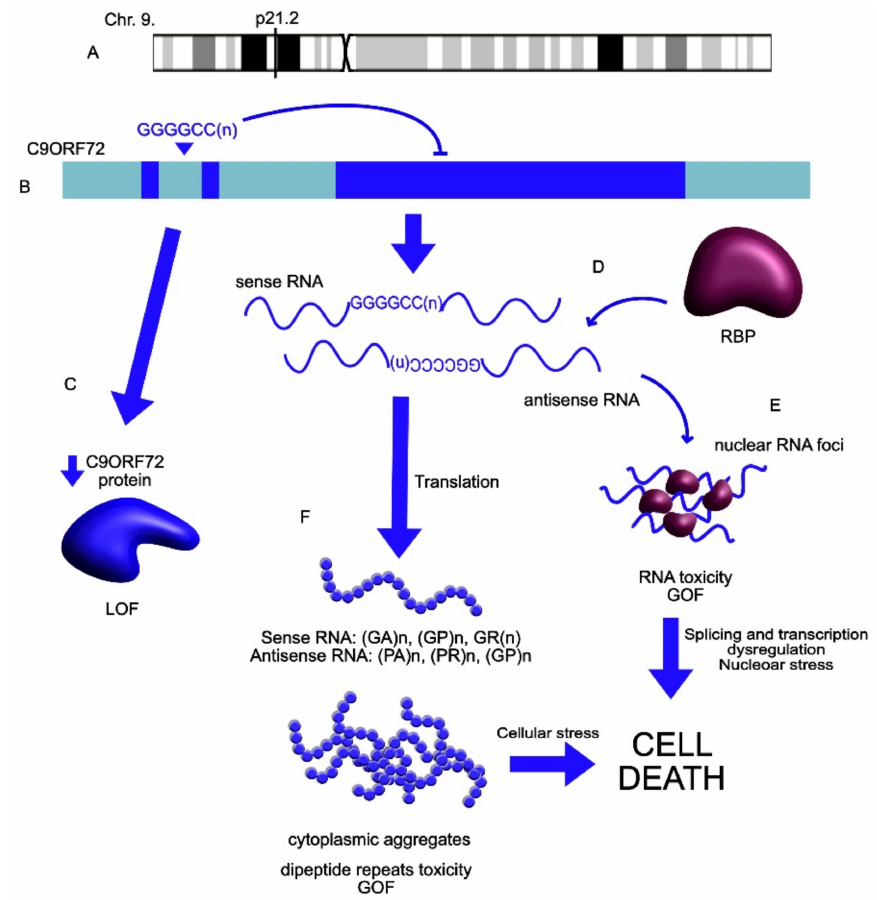
Figure 6. C9ORF72 ’s role in ALS pathophysiology. ( A ) The C9ORF72 locus is localized on chromo- some 9 (www.genecards.org, accessed on 28 April 2021). ( B ) In ALS patients, in C9ORF72, there have been observed a significantly extended number (>30) of GGGGCC repeats in the gene. ( C ) This mutation leads to impaired translation of the protein and its loss of function (LOF). ( D ) The sense and the antisense transcripts bind to RNA-binding proteins (RBP) forming nuclear foci and forming toxic aggregates (GOF: gain of function), which affects cellular processes such as splicing, transcription and nucleocytoplasmic transport and leads to nuclear stress ( E , F ). These transcripts are further translated into misfolded proteins, which can form toxic dipeptide aggregates (GOF). All the toxic cellular inclusions lead to cellular stress and eventually cell death (GA: glycine–alanine; GP: